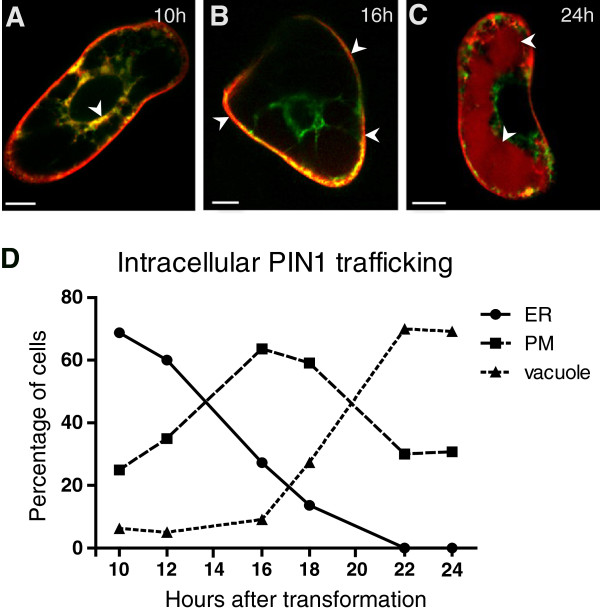
Cellular localization and trafficking of PIN1-RFP. (A) Colocalization of PIN1 proteins (in red) with the ER marker HDEL-GFP (in green) 10 h after transformation. (B) PIN1-RFP preferentially localizes to the plasma membrane (PM) after 16 h. (C) 24 h after transformation, PIN1-RFP shows vacuolar localization indicating lytic turnover. (D) Relative number of cells showing pronounced PIN1-RFP signal in the ER, PM, and in the vacuole over a time course of 24 h after transformation. Cells showing PIN1-RFP both at PM and either at the ER or vacuole were ascertained as ER or vacuole positive, respectively. Bars = 10 μm.